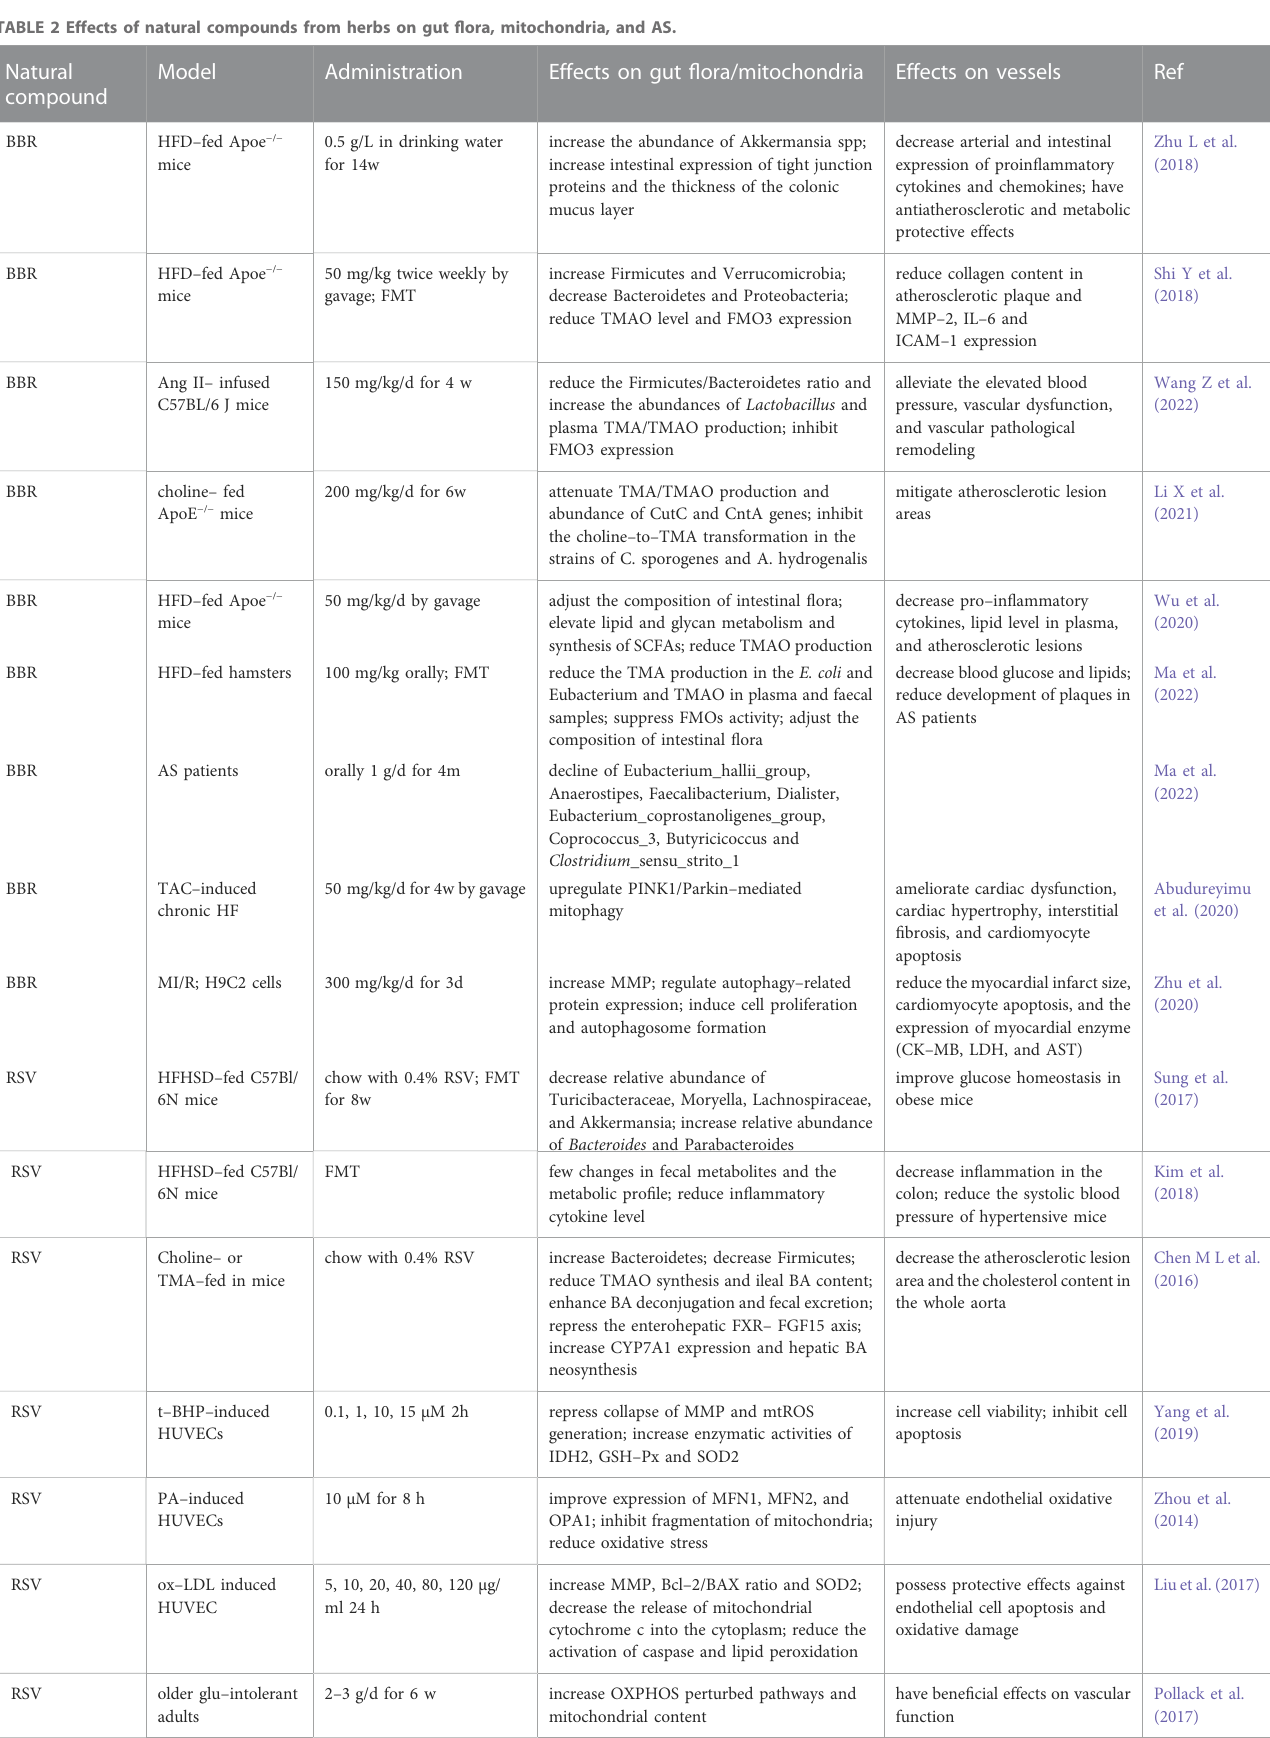
TABLE 2 Effects of natural compounds from herbs on gut fl ora, mitochondria, and AS. Natural